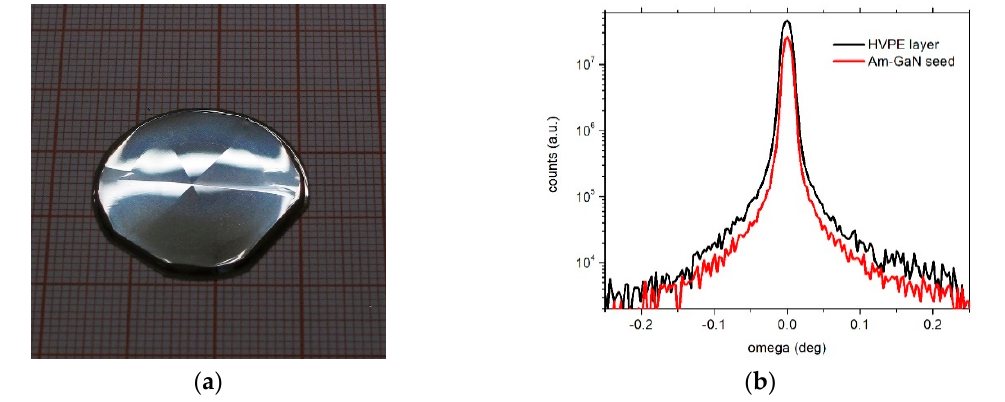
Figure 8. HVPE-GaN grown on Am-GaN seed at IHPP PAS: ( a ) morphology; one central hillock is well visible; ( b ) X-ray rocking curve of Am-GaN seed and FS HVPE-GaN layer; full with half maximum (FWHM) for (00.2) reflection keeps the same value as Am-GaN seed: 43 arcsec and 50 arcsec, respectively.